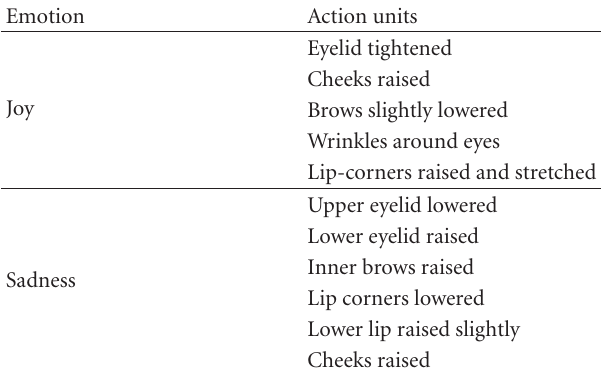
Table 1: Examples of action units for universal expression of joy and sadness